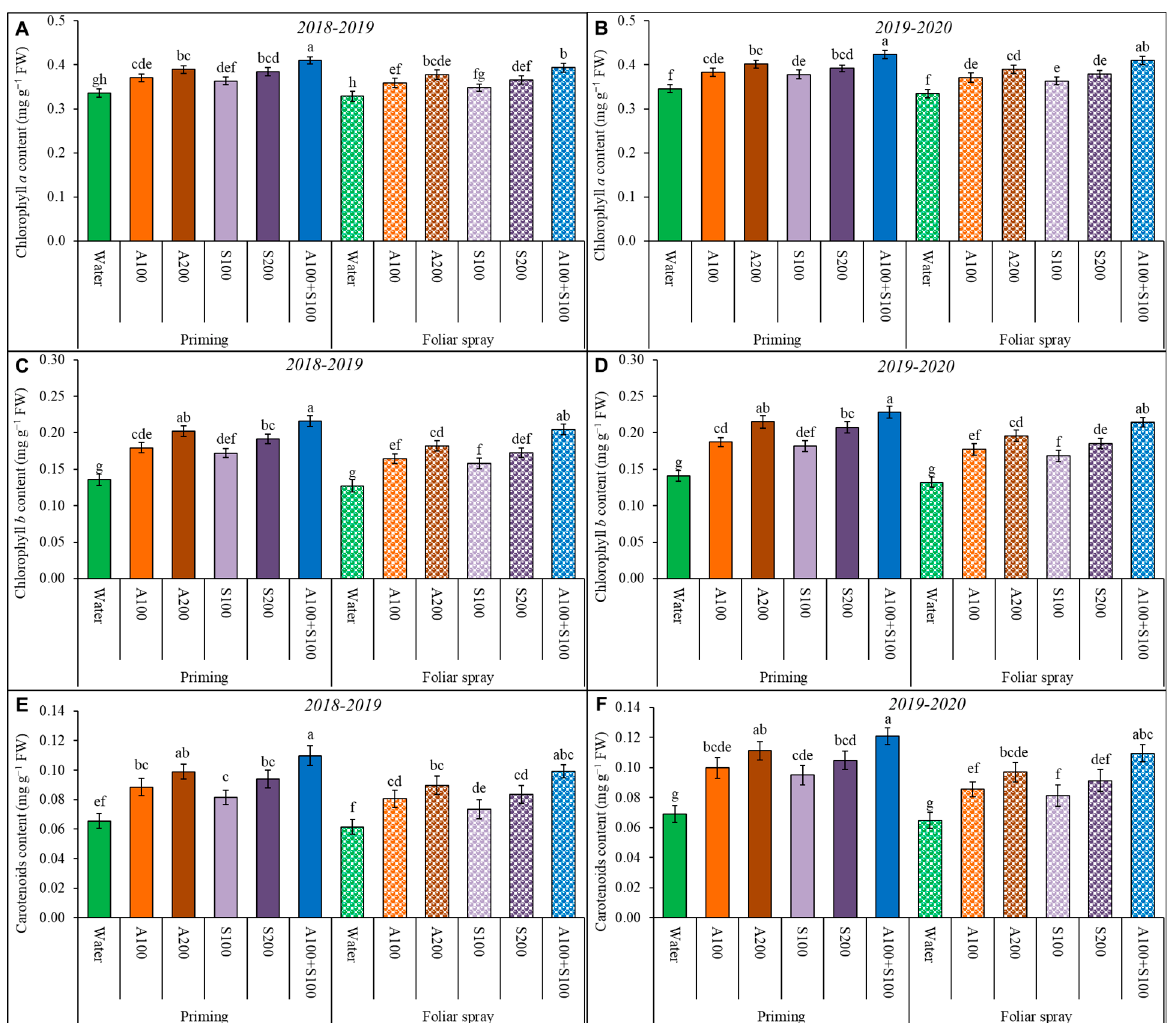
Figure 2. Photosynthetic pigments of wheat leaves affected by AA and SA treatments in the two winter seasons 2018/2019 and 2019/2020. ( A , B ): chlorophyll a , ( C , D ): chlorophyll b , and ( E , F ): carotenoids. Data are mean ± standard error ( n = 4). Letters represent significant differences between treatments at p < 0.05 level according to LSD test.